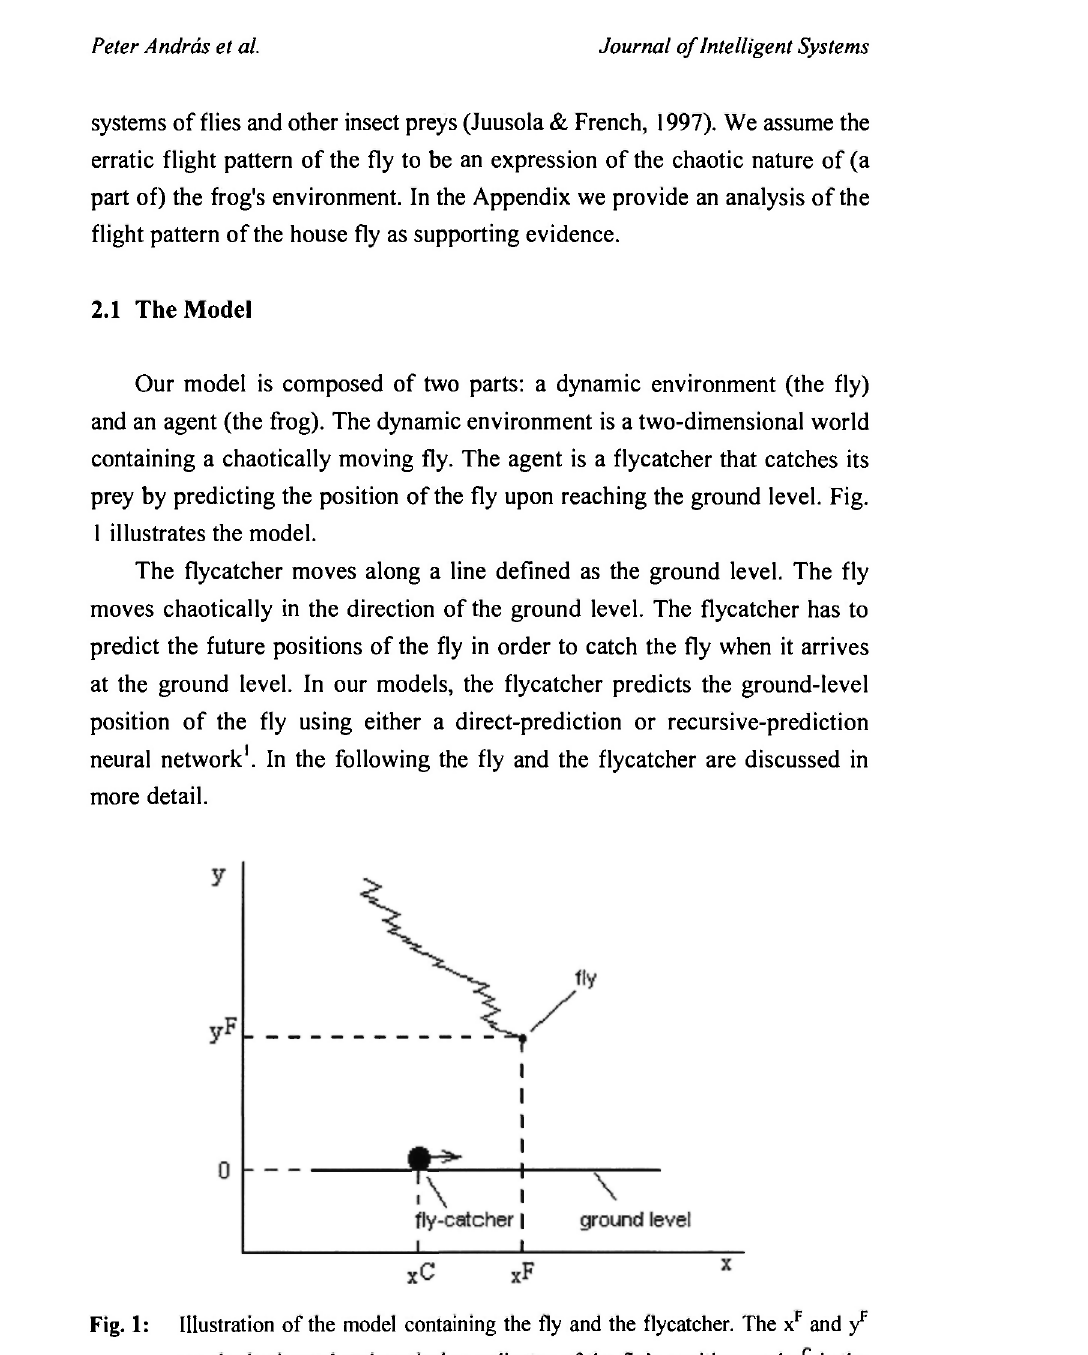
are the horizontal and vertical coordinates of the fly's position, and x c is the horizontal coordinate of the flycatcher's